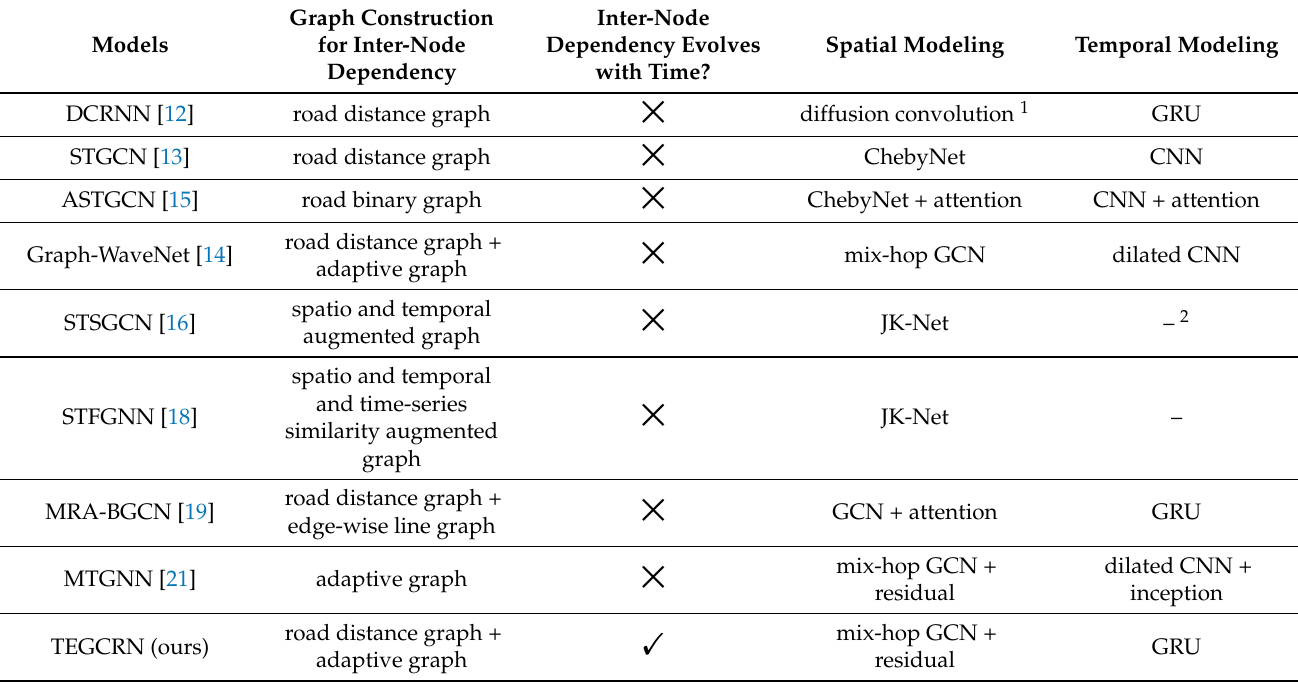
Table 1. The comparison table of graph-based traffic prediction